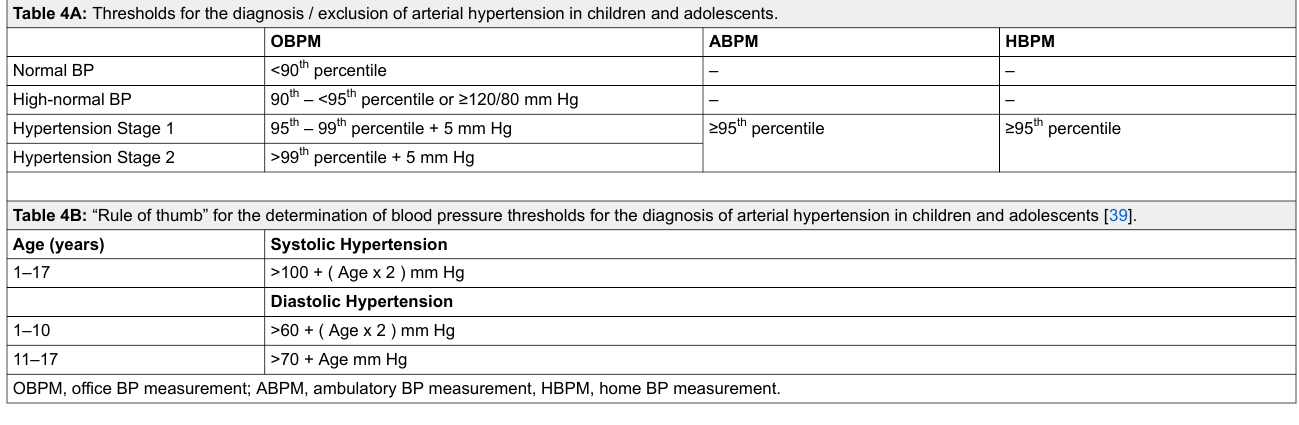
Table 4A: Thresholds for the diagnosis / exclusion of arterial hypertension in children and adolescents. OBPM ABPM HBPM Normal BP